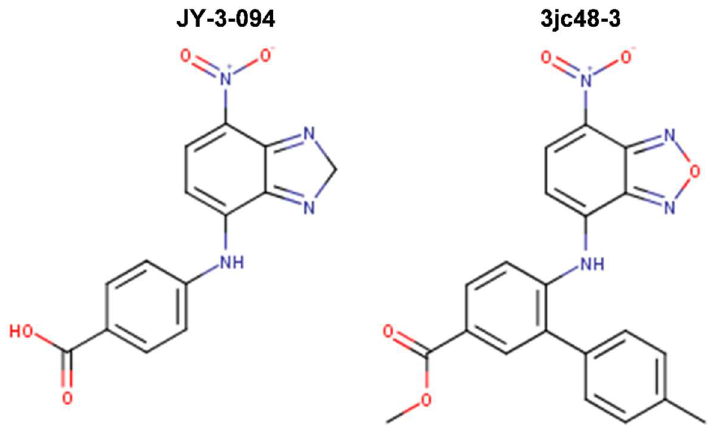
Figure 6. Chemical structures of JY-3-094 and 3jc48-3, improved analogs of compound 10074-G5.